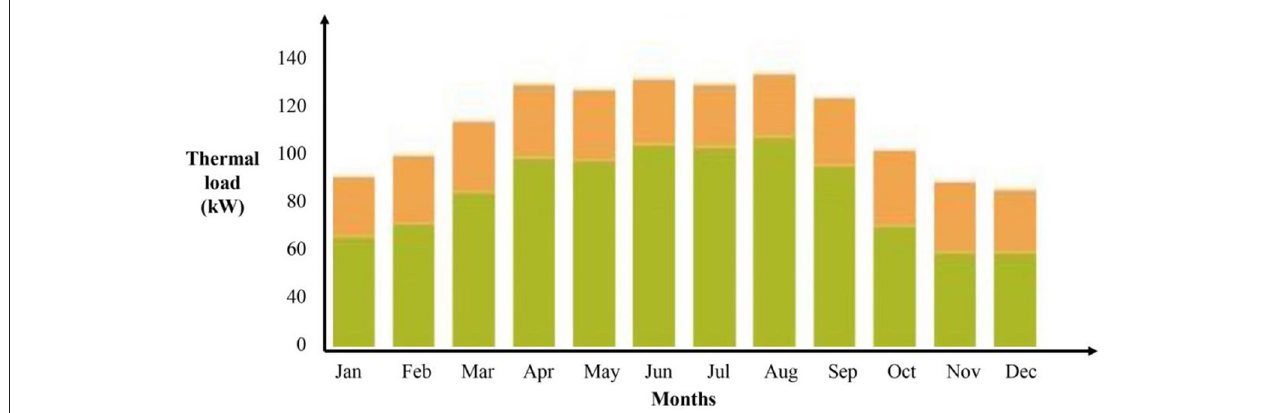
FIGURE 13 | Average monthly electricity production by PV and grid.